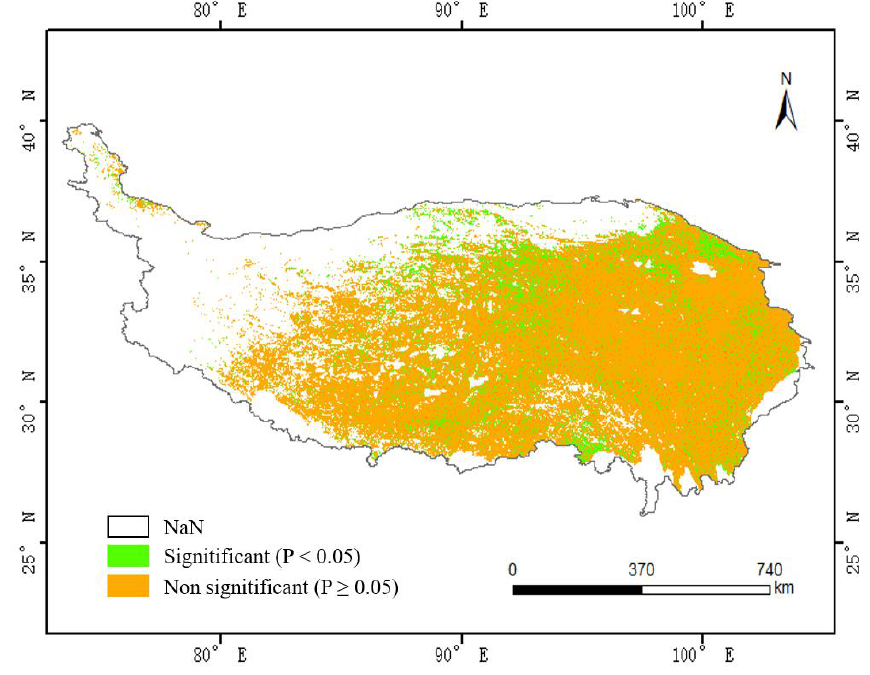
Figure 13. The significance test of correlation coefficient.